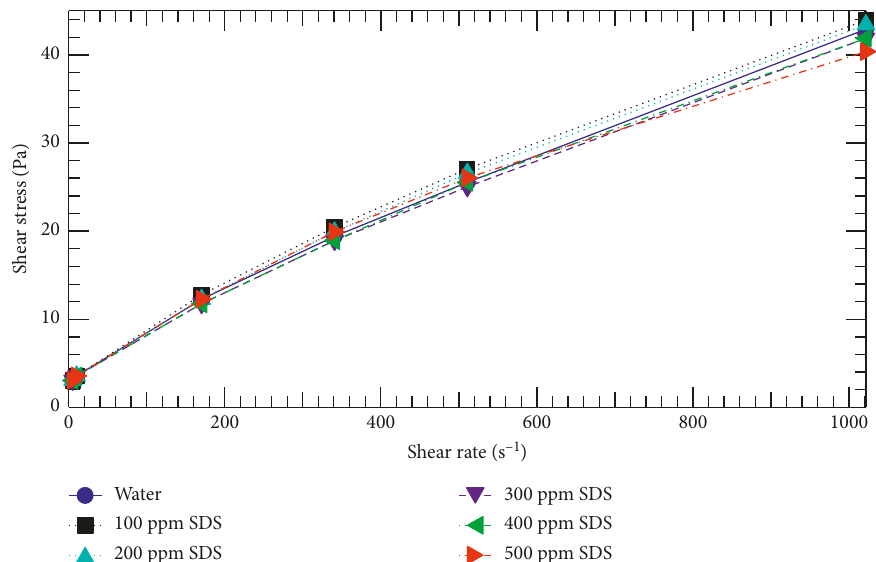
Figure 9: Rheogram of water-based drilling fluid with 0.1 ppb of graphene nanoplatelets dispersed using SDS.